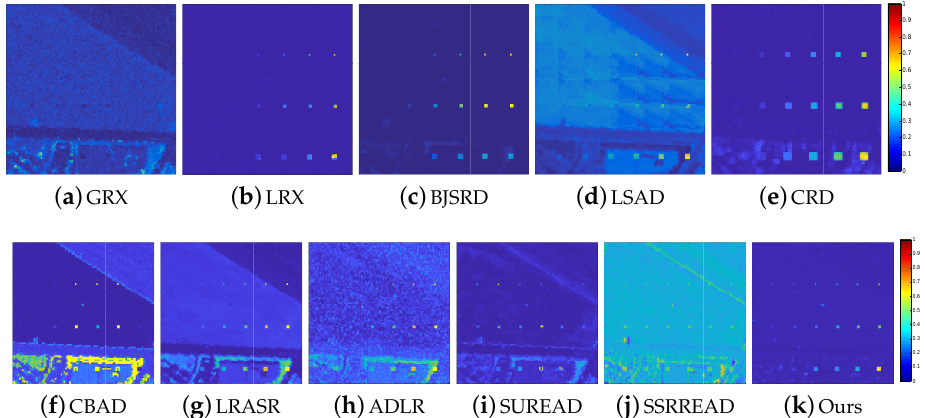
Figure 7. 2-D target probability color maps of the detection algorithms for the simulated dataset.